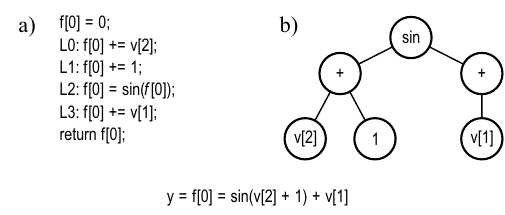
Fig. 3. A comparison of a GP program structure evolved by: (a) LGP; (b) Classical tree-based GP